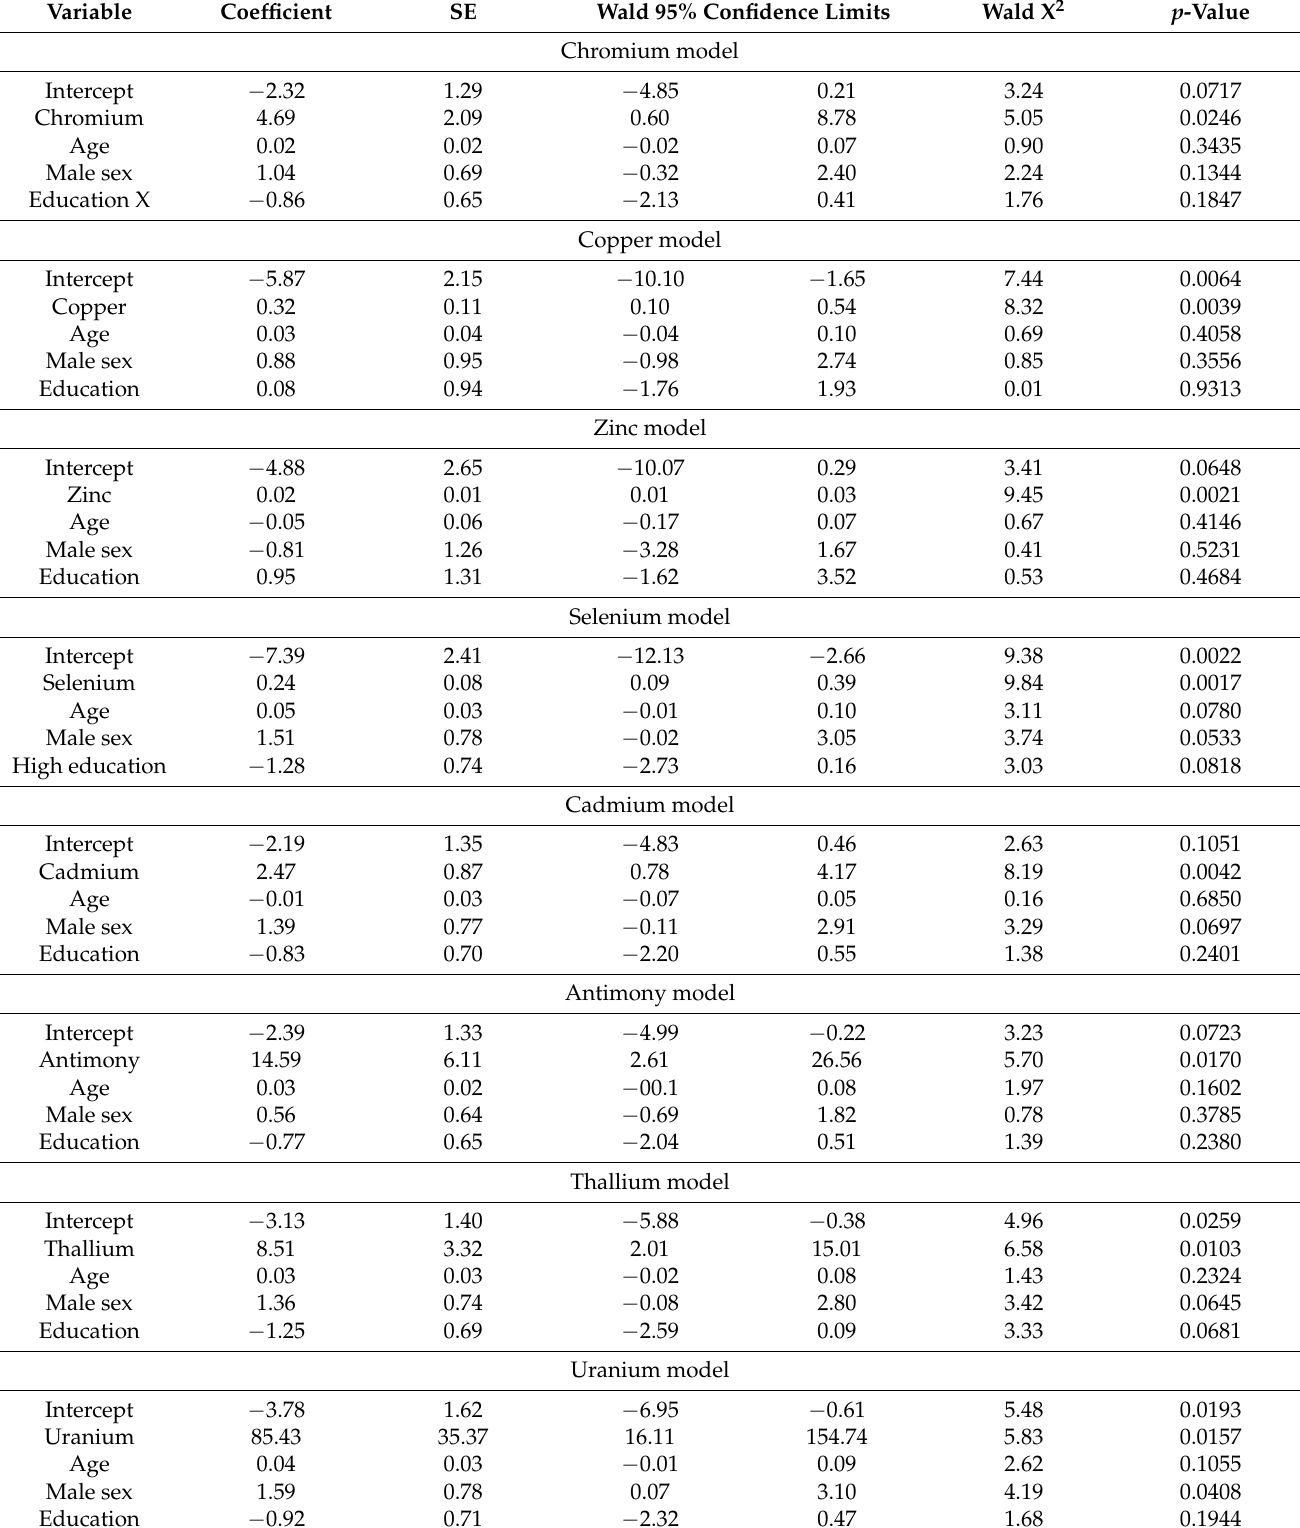
Table 4. Adjusted models of DCM prediction by urine metal concentrations ( N =